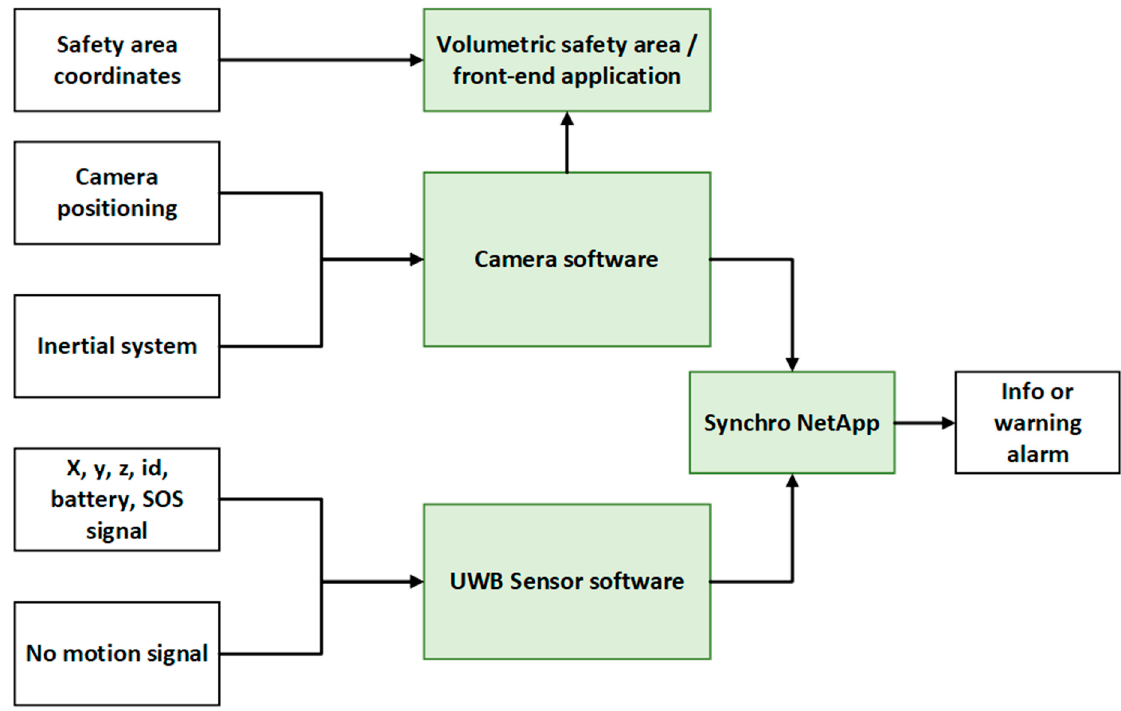
Figure 9. NetApp architecture of